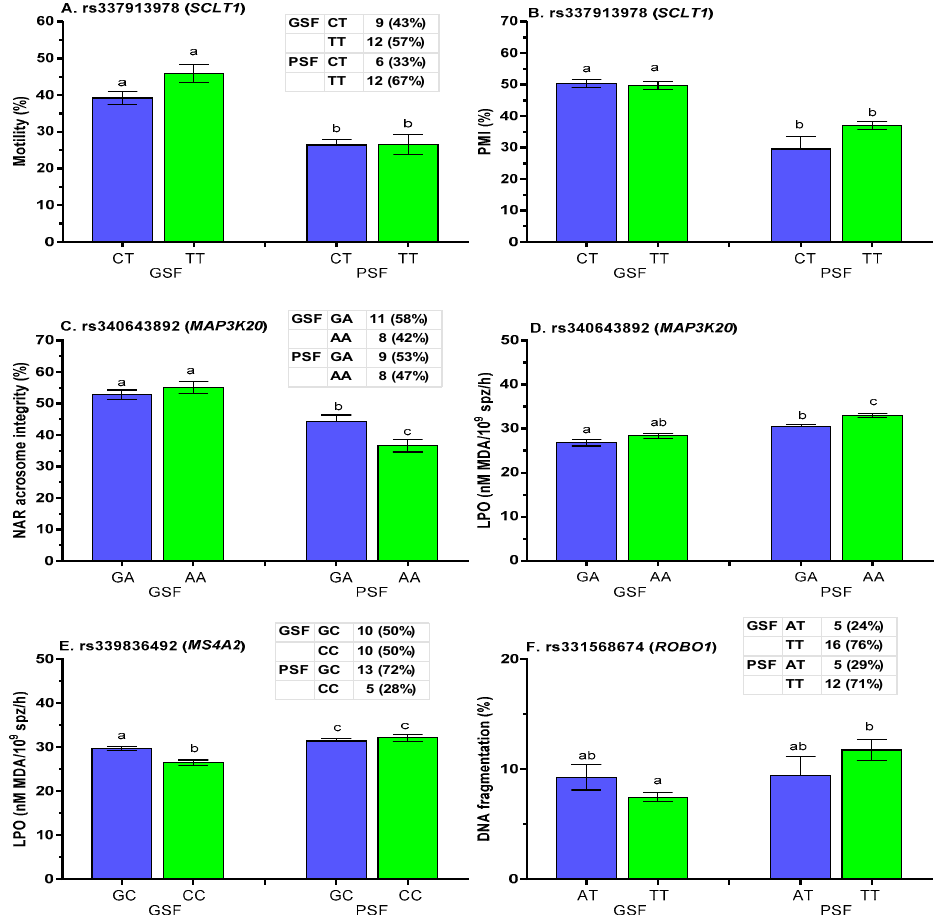
Figure 7. Effect of freezability and gene polymorphisms in A–B . SCLTL1 , C–D . MAP3K20 , E . MS4A2, and F . ROBO1 genes on post-thaw quality of boar semen. Data are presented as the mean ± SEM. a,b Di ff erences between genotypes were significantly di ff erent at p < 0.05; GSF—good semen freezability; and F . ROBO1 genes on post ‐ thaw quality of boar semen. Data are presented as the mean ± SEM. a,b Differences between genotypes were significantly different at p < 0.05; GSF—good semen freezability; PSF—poor semen PSF—poor semen freezability.